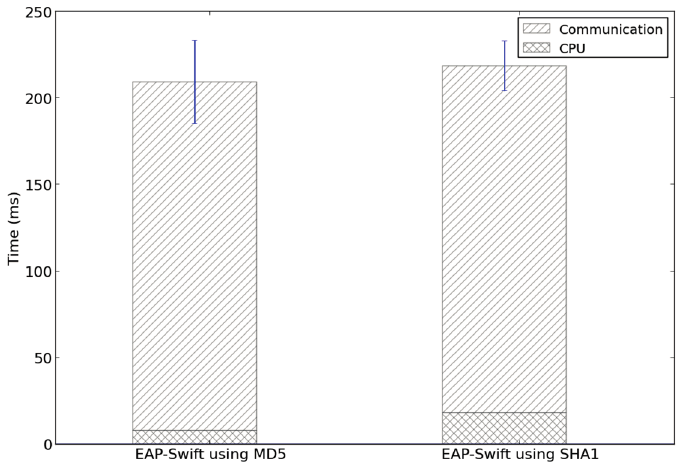
Figure 6. Measured total authentication time for the EAP-Swift implementations based on MD5 and SHA1.